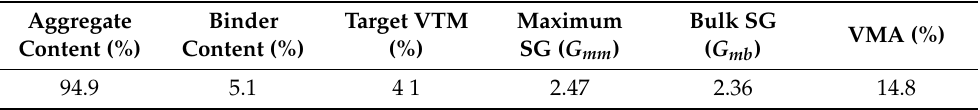
Table 6. Asphalt mix volumetric data.